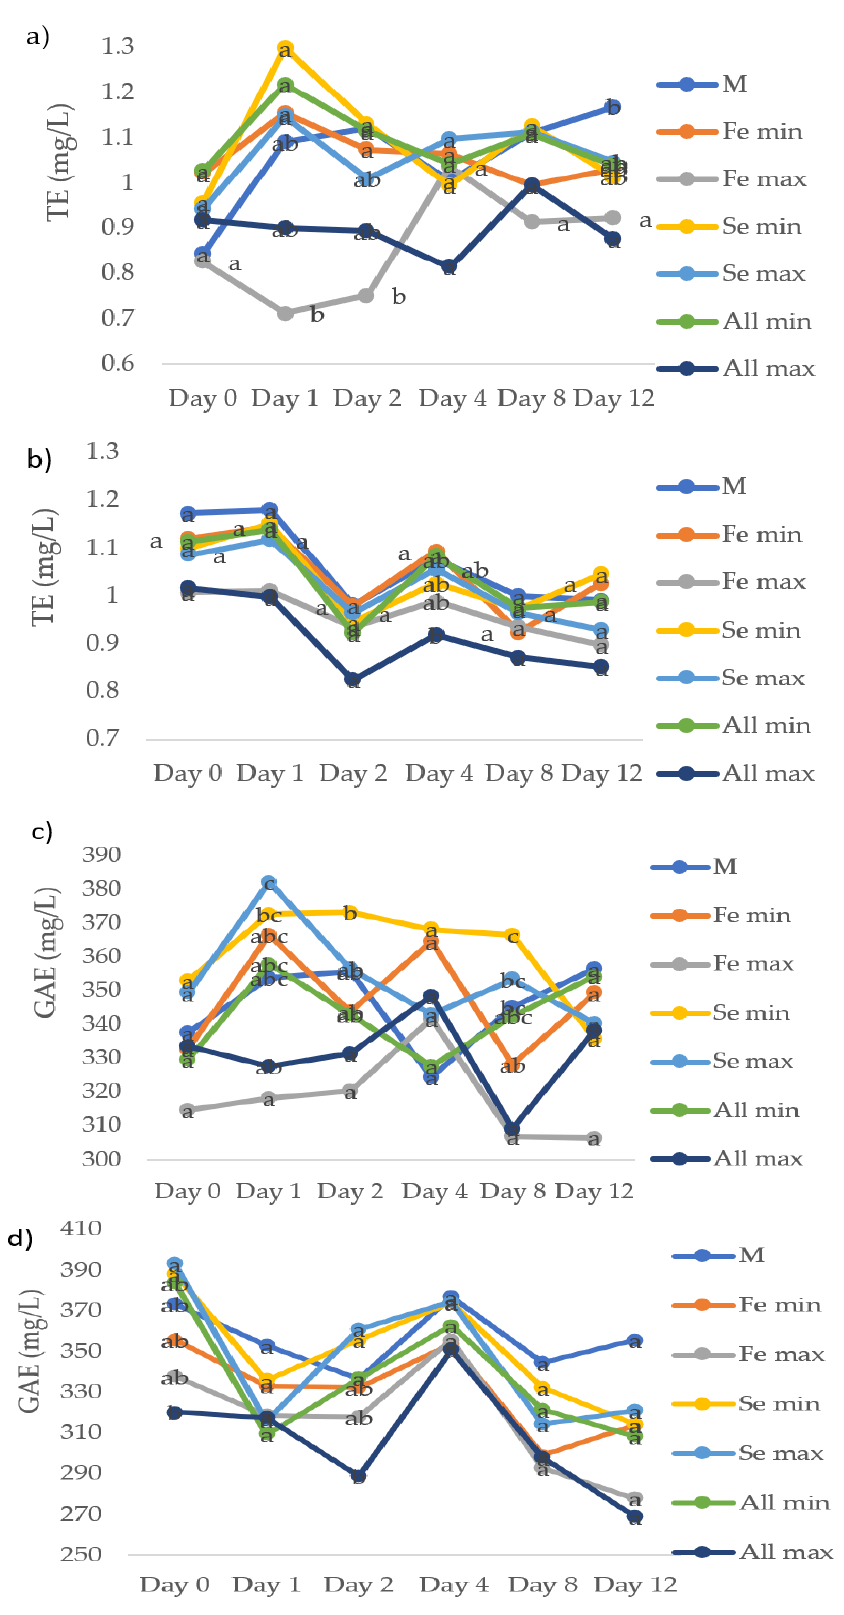
Figure 3. Change of antioxidant activity (TE mg/L) ( a , b ) and total phenols ( c , d ) GAE (mg/L) of the samples during 12 days of heating at 35 and 50 ◦ C, respectively. Different letters at each temperature studied indicate statistically significant differences ( p < 0.05). Sample codes are described in Table